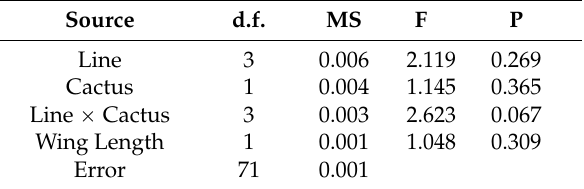
Table 3. Analysis of variance testing for differences in ovariole number in D. koepferae. Source